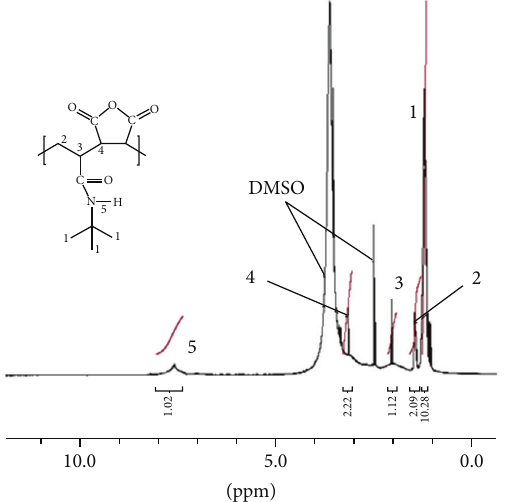
Figure 4: 1 H NMR spectra of poly(NTBA-co-MA) in DMSO- d 6 at 50 ∘ C.